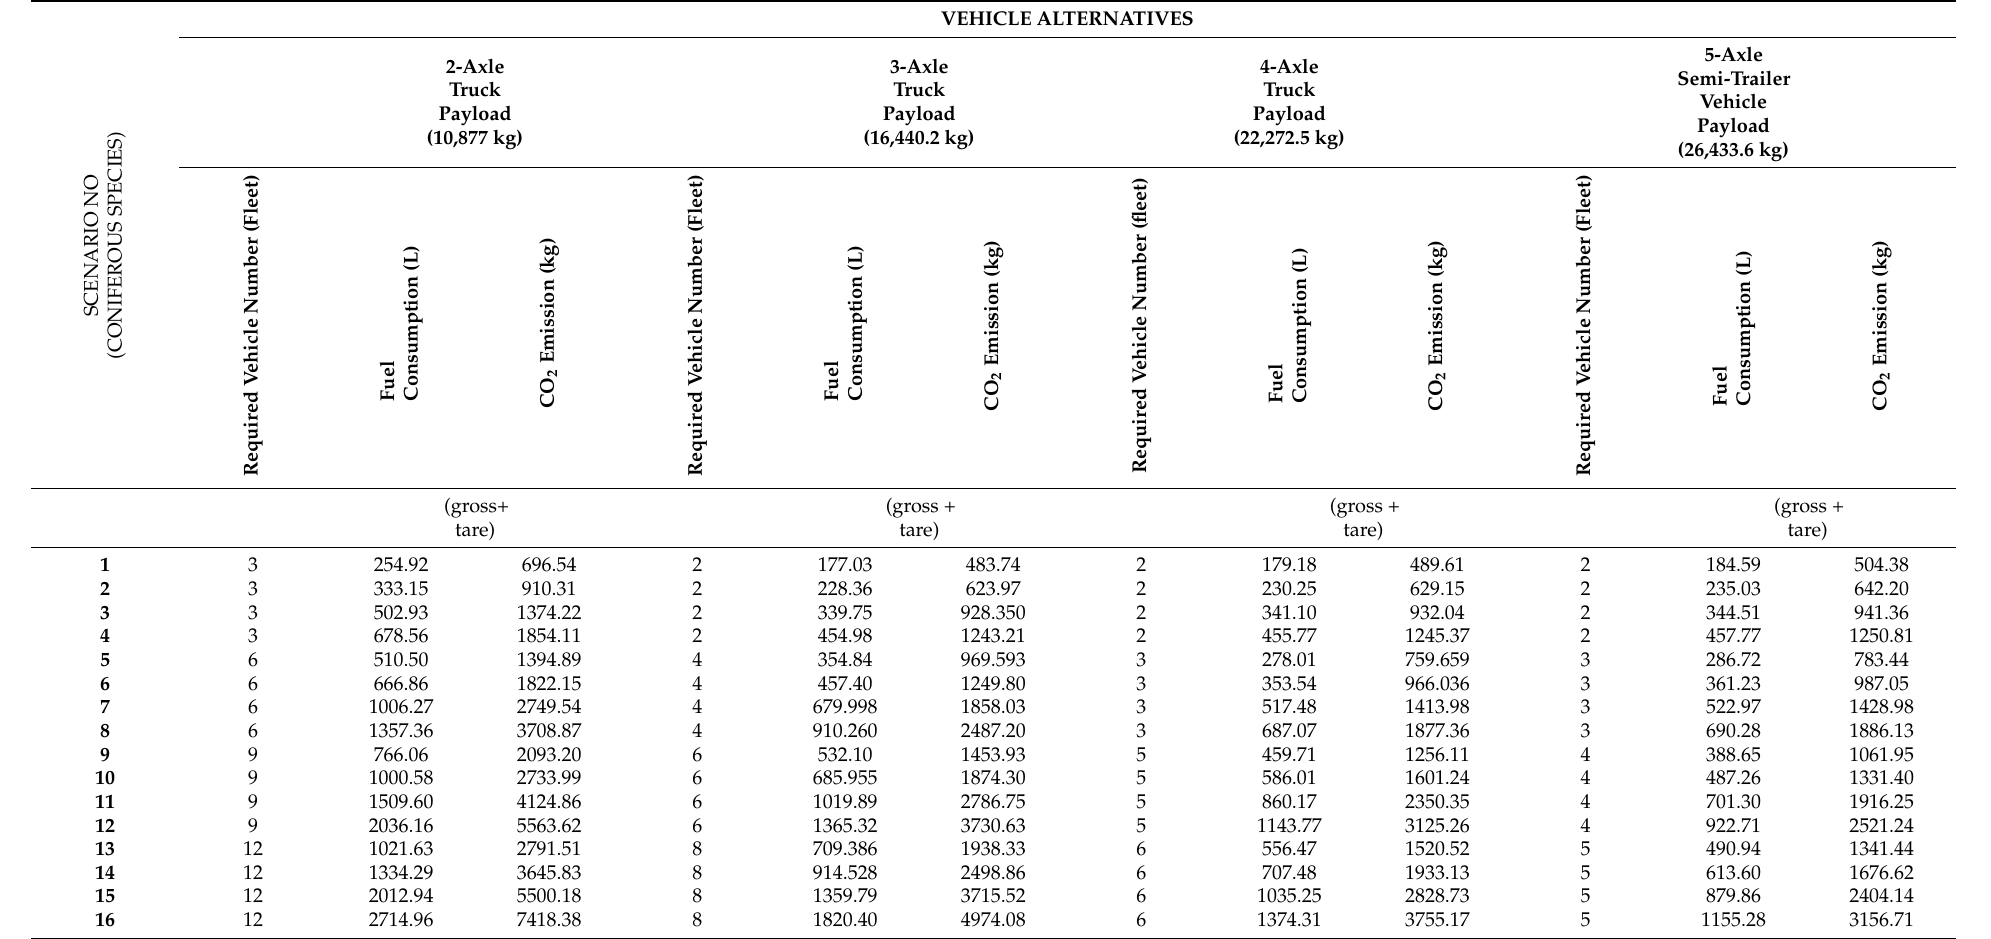
Table 17. Fuel consumption and CO 2 emission values in terms of coniferous species according to transportation